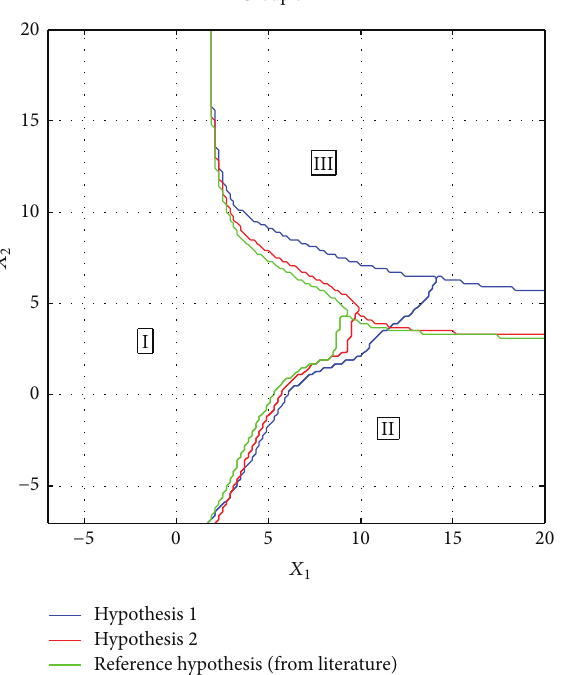
Figure 19: Setup policy (product 2 to product